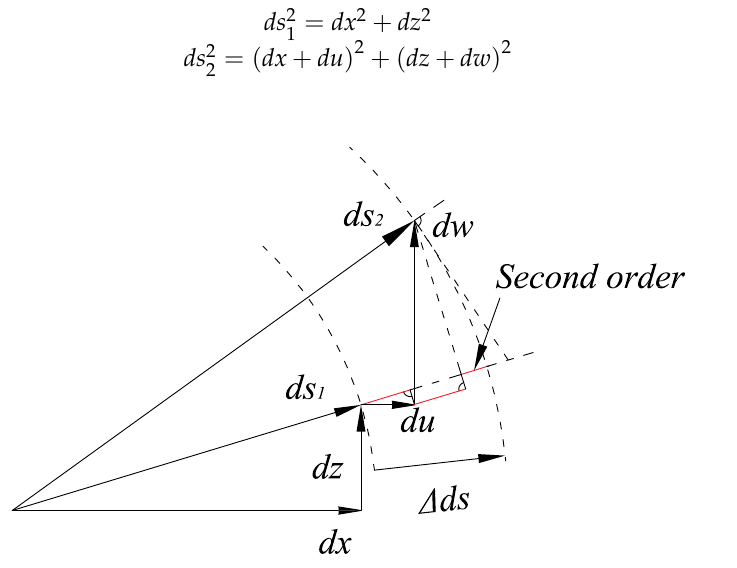
Figure 2. Displacement of an element of the cable. (Adapted from [16]).